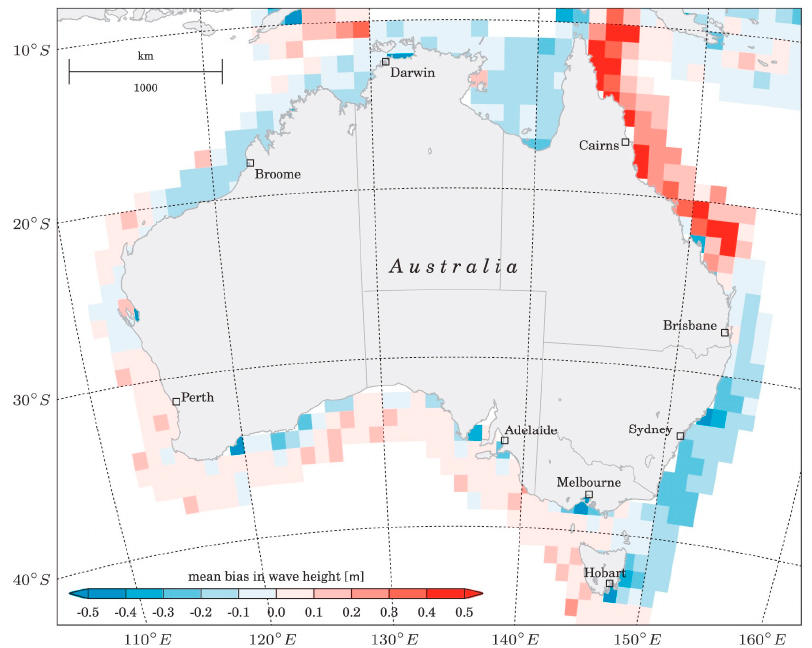
Figure 14. Spatial variability of the mean bias of the modelled significant wave height (Hs in units of m) relative to observations from altimeters (hindcast model minus altimeter). Figure obtained from Hemer , et al. [28] .